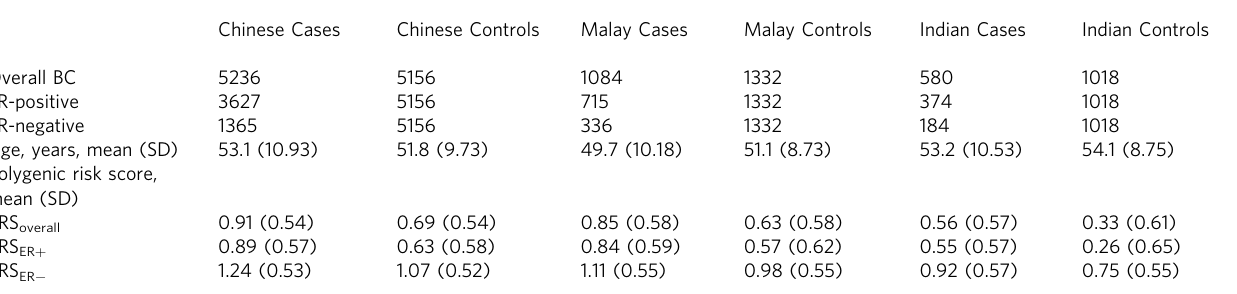
Table 4 Characteristics of women in Malaysian Breast Cancer Genetic Study and Singapore Breast Cancer Cohort.